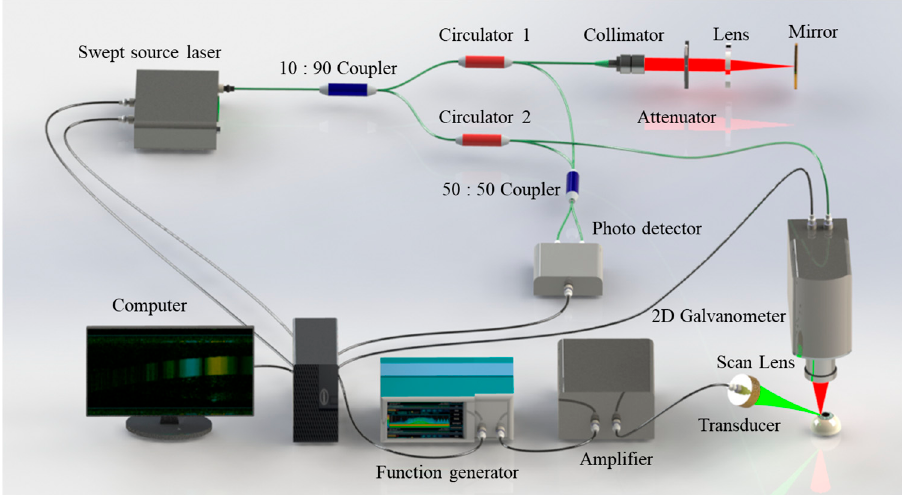
Figure 1. The schematic of the corneal OCE system setup.